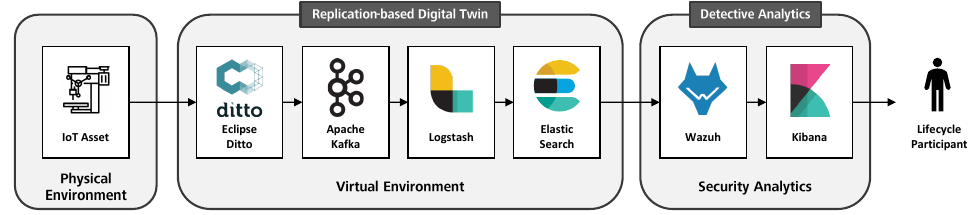
Figure 5. T WINSIGHT setting implemented in the research project